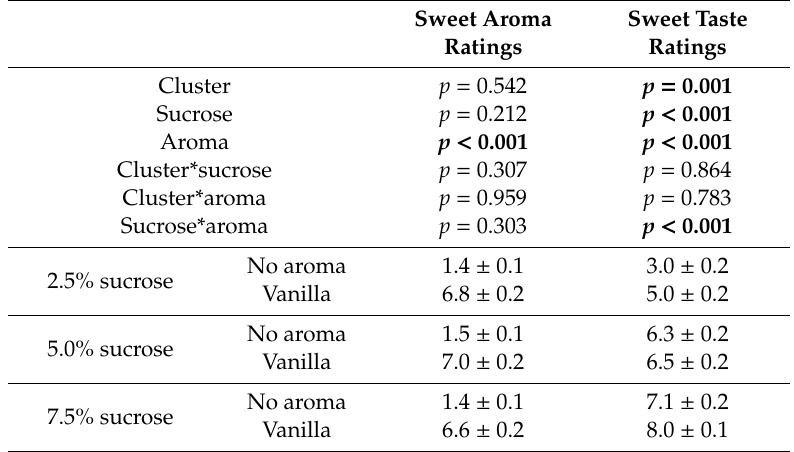
Table 5. Means ± std. errors for the ratings of sweet aroma and sweet taste intensity as well as p -values for the factors in the models. Significant e ff ects are marked in